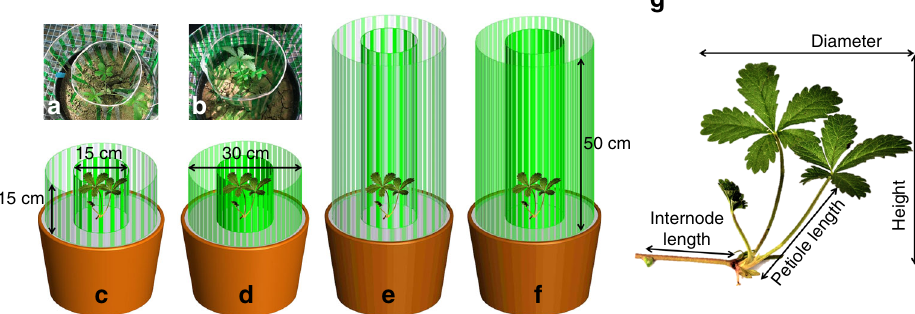
Fig. 4 Graphic representation of the experimental design and measured variables. The experiment included treatments that simulated short-sparse a , c , short-dense b , d , tall-sparse e and tall-dense f neighbouring vegetation. Included are representative photographs of the short-sparse a and short-dense b treatments with P. reptans in the middle of the pots. Dense vegetation d , f was simulated using strips of transparent green plastic fi lters that mimic vegetative shade in both light transmission levels and R:FR ratios, while sparse vegetation c , e was simulated with alternating green and clear strips (see Materials and Methods). A photograph of P. reptans is included with a description of some of the measured variables g